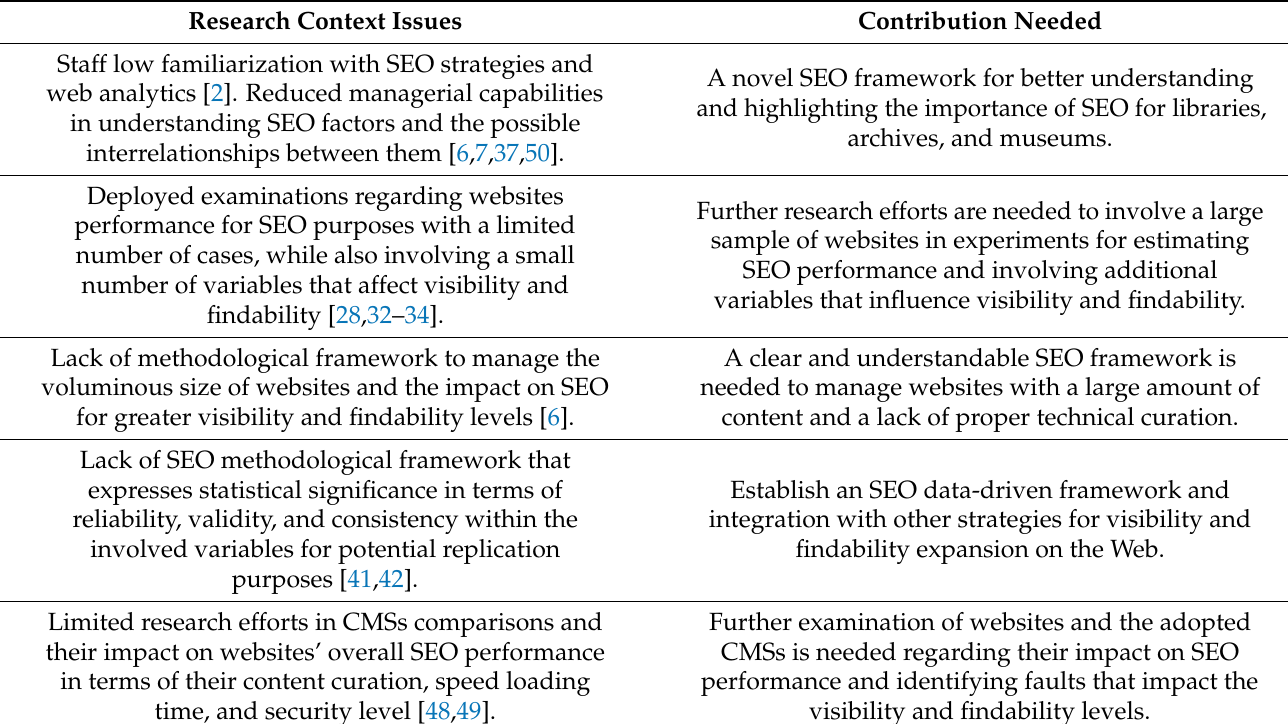
Table 1. Reflections and context issues for SEO and new research avenues for the improvement of visibility and findability of websites on the